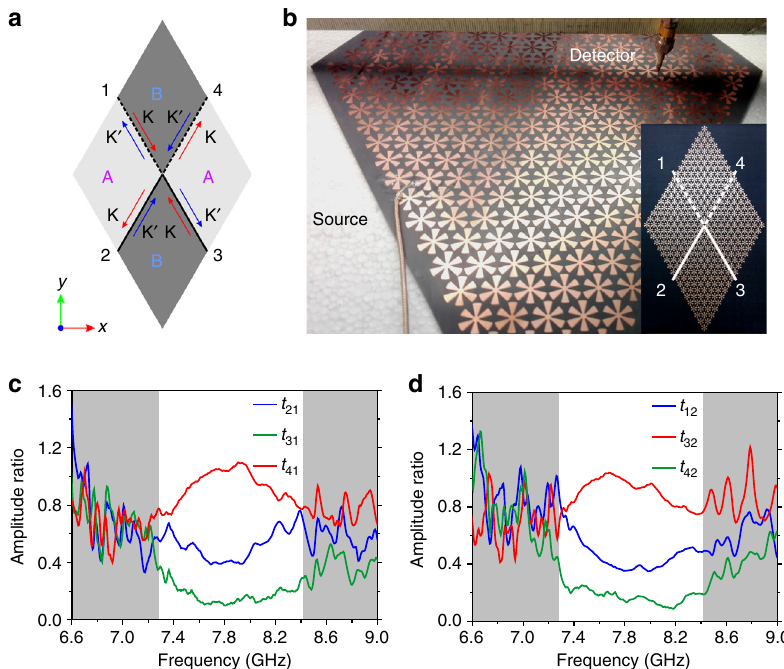
Fig. 4 Topological transport of valley-polarized edge states. a Schematic diagram of the beam splitter used for selective excitation of valley-polarized edge states. The beam splitter comprises two domains of patterns A and two domains of patterns B. The black dashed lines and solid lines represent AB-type domain walls and BA-type domain walls, respectively. The red and blue arrows represent edges states near K and K ′ valleys, respectively. b Photograph of the experiment setup. Two monopole antennas are used in experiments (see Methods section). DSPs are excited by one of the antennas and E z component of the transmitted wave is measured by the other one. Inset shows a top-view photograph of the fabricated beam splitter. c , d Measured E z amplitude ratio t ij (outgoing terminal i , incident terminal j ) when the source is placed at terminal 1 ( c ) or terminal 2 ( d ). The unshaded region corresponds to the bandgap obtained from experimental